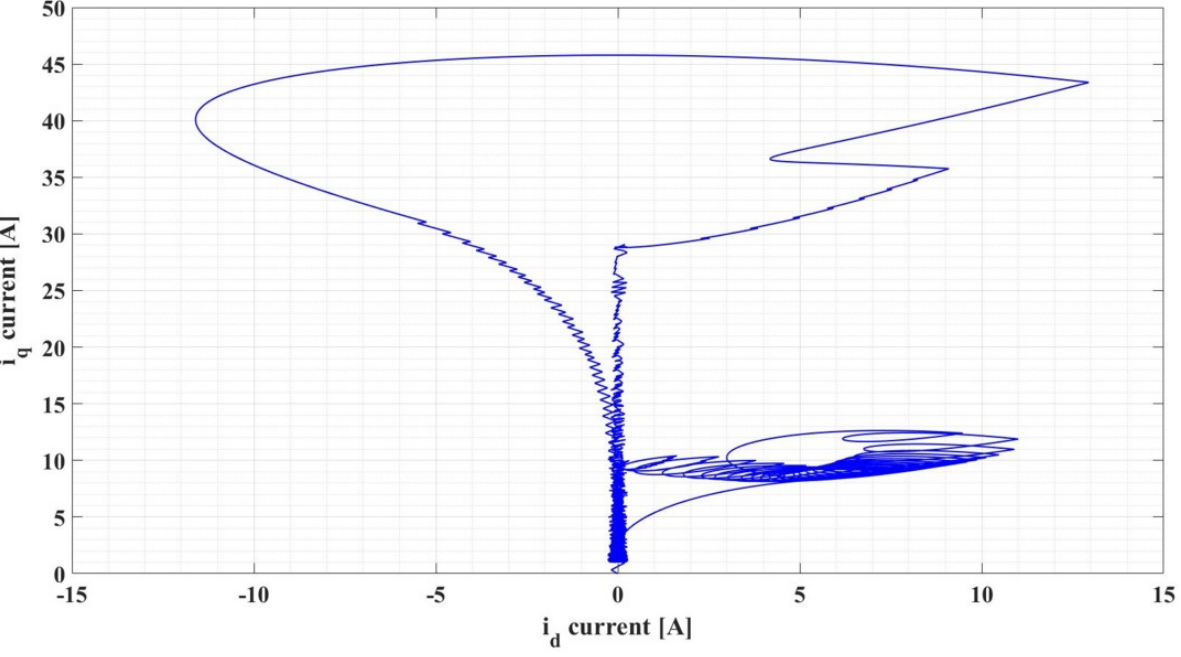
Figure 28. Image of the phase plan for PMSM variable structure with switching signal type 2: rotor speed versus i d current ( ω ref = 800 rpm). Figure 29. Image of the phase plan for PMSM variable structure with switching signal type 2: rotor speed versus i d current ( ω ref = [800, 1200] rpm).